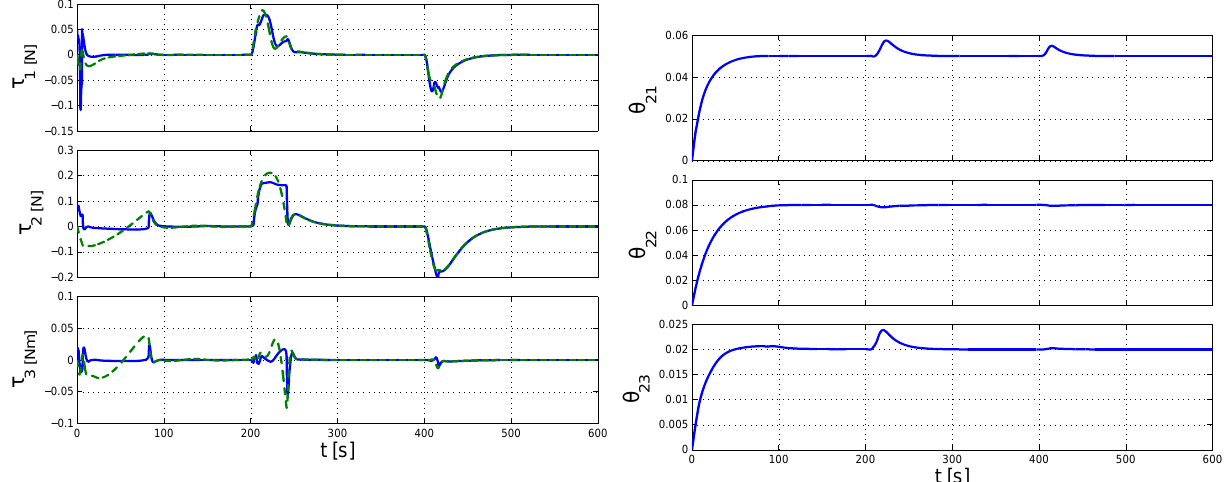
Figure 5: The virtual control (dashed) and actual (solid) forces generated by the actuators